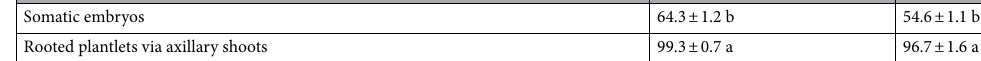
Tranplantation survival (%) in different regeneration